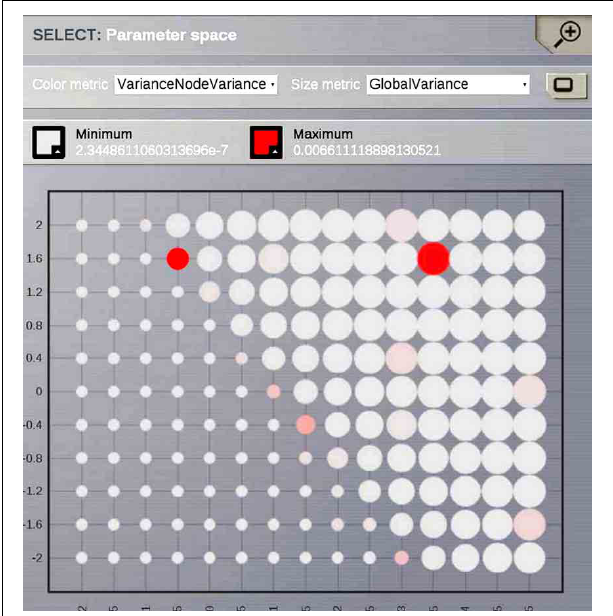
FIGURE 10 | One of TVB’s major strengths is the capability to launch parallel simulations through the UI. We show a screenshot of the resulting display when sweeping across two different parameters of the Generic2dOscillator model. Here each data point represents two metrics: size is mapping the Global Variance and color corresponds to the Variance of the nodes Variance . These results provide a topography of the stability space allowing users to distinguish, and thus select, combinations of critical parameters values.